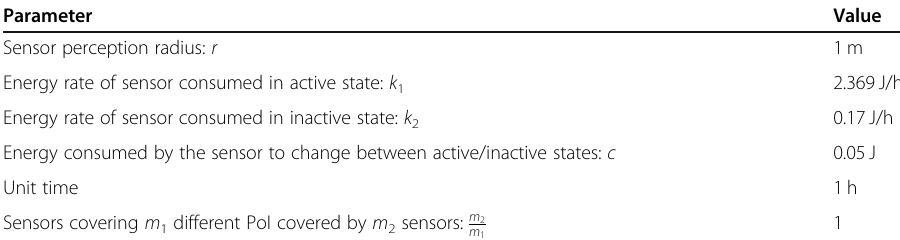
Table 2 Experimental parameter setting Parameter Value Sensor perception radius: r 1 m Energy rate of sensor consumed in active state: k 1 2.369 J/h Energy rate of sensor consumed in inactive state: k 2 0.17 J/h Energy consumed by the sensor to change between active/inactive states: c 0.05 J Unit time 1 h Sensors covering m 1 different PoI covered by m 2 sensors: m 2 m 1